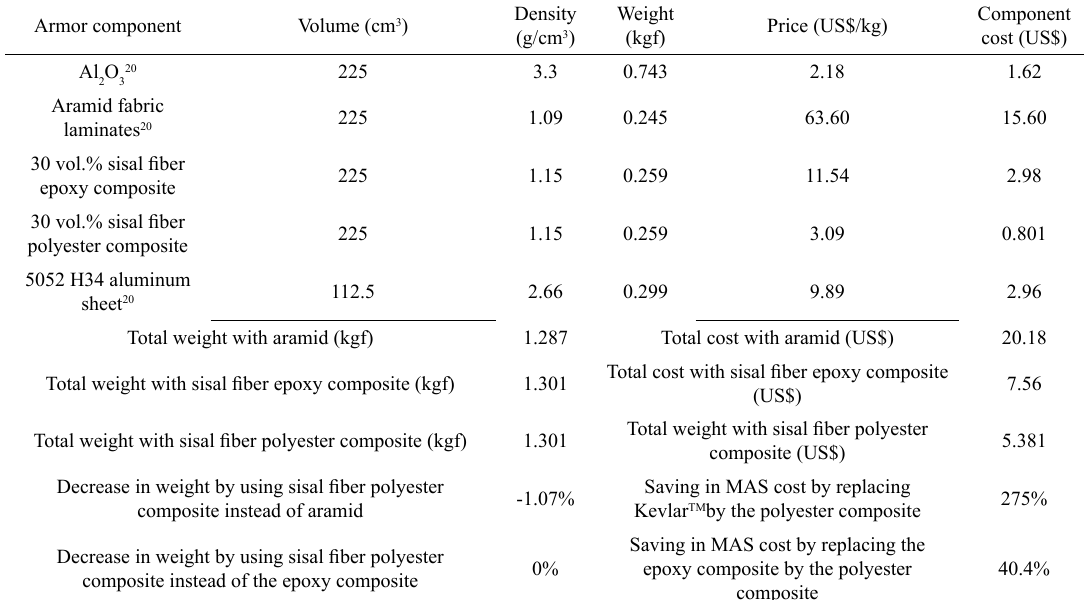
Table 5. Evaluation of weight and cost of the different multilayered armor